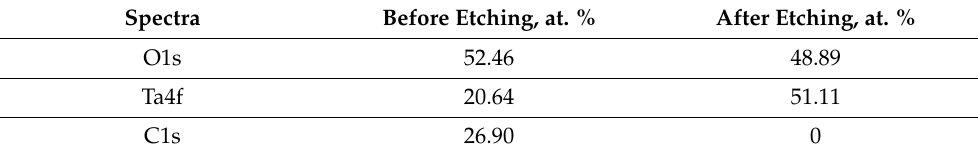
Table 3. Atomic ratios of elements before and after etching according to XPS data. Spectra Before Etching, at. % After Etching, at.